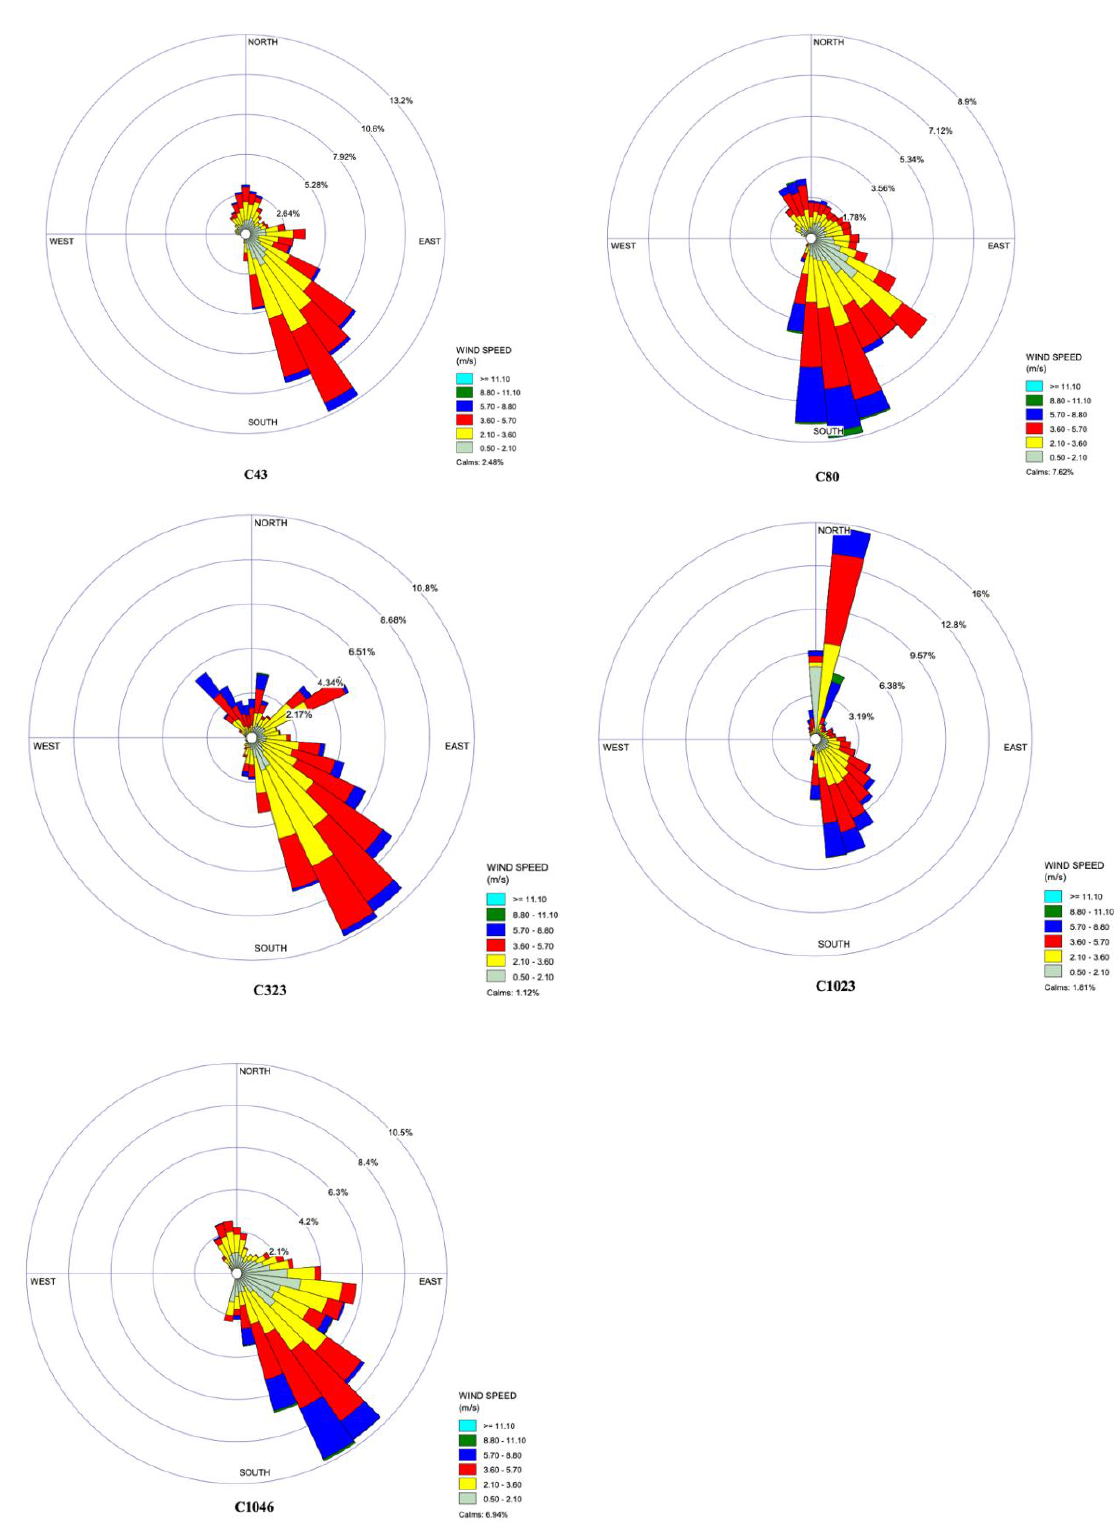
Figure 2. Wind rose diagrams for the RGV CAMSs C43, C80, C323, C1023, and C1046 during the study duration from 1 March 2021 to 31 March 2022.